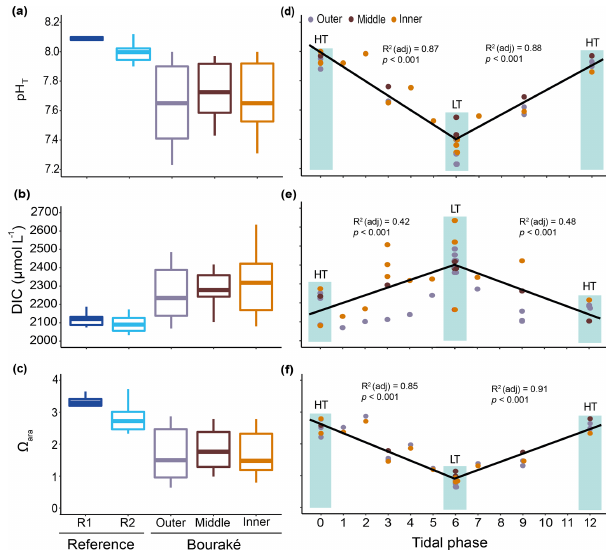
Figure 8. Seawater carbonate chemistry measured (pH T ) and cal- culated (DIC and (cid:127) ara ) during diel cycles in 2017 and 2019 (pooled data; see also Fig. S1) at R1, R2, and the Bouraké reefs (outer, mid- dle, and inner) (a–c) . Boxes ( n = 6–14) represent the interquartile range (25th and 75th percentiles); the horizontal line is the me- dian, and the whiskers represent the data range (i.e., minimum and maximum). Changes are illustrated across a 12h tidal phase in the Bouraké lagoon (d–f) . Linear regression lines are plotted for each falling (HT to LT) and rising (LT to HT) tide. Shaded boxes have only a graphical significance and only suggest the tide changes dur- ing